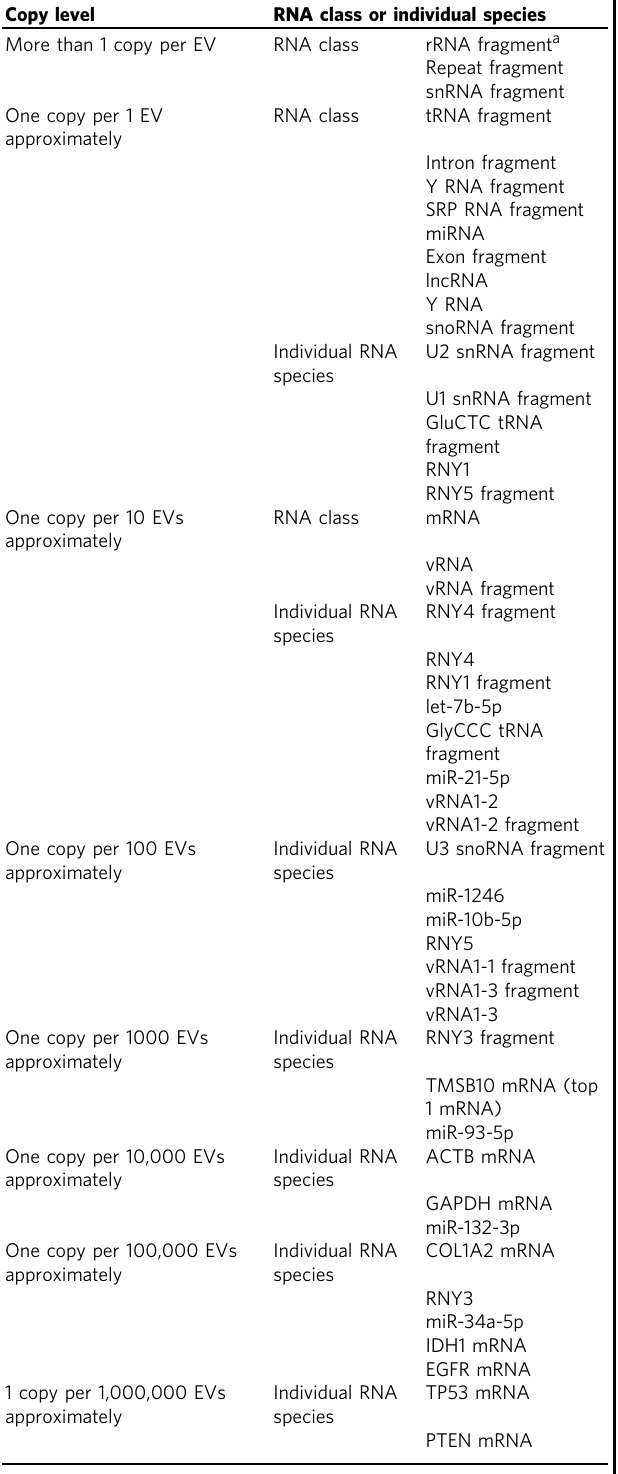
Table 1 Quanti fi cation of selected RNA classes and individual species in copy number per